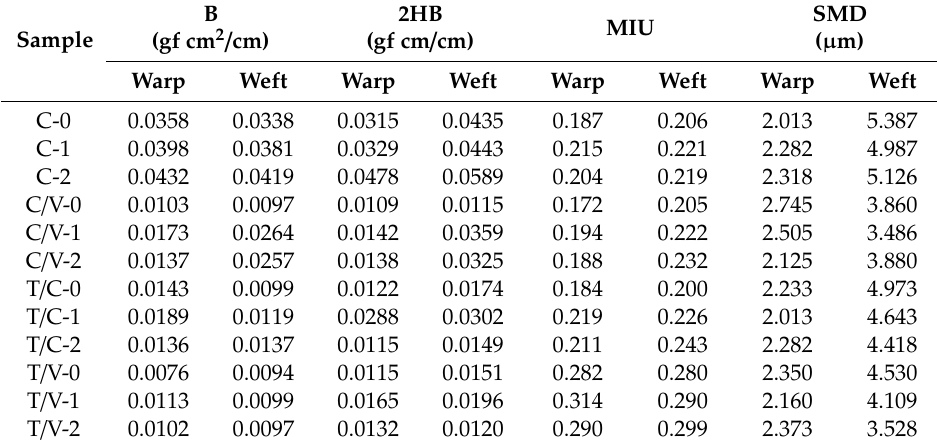
Table 4. Bending properties and surface friction properties of original and treated